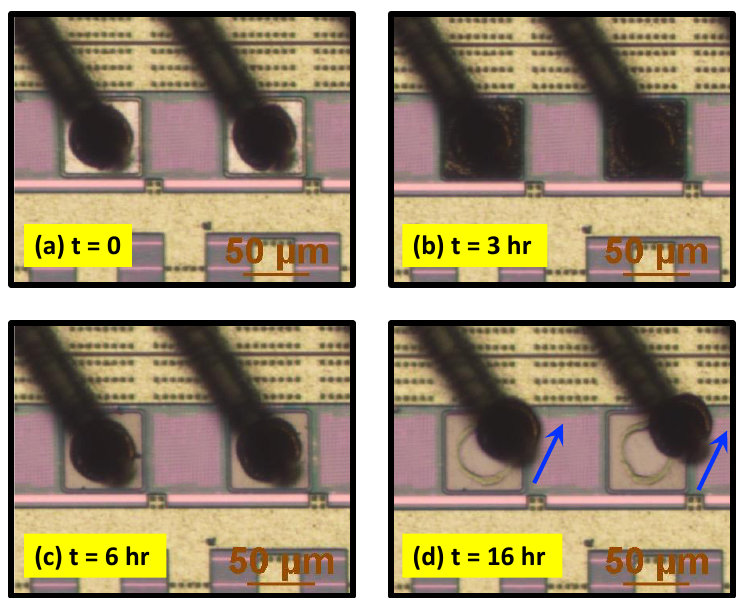
Figure 11. Real-time corrosion progression of WBD (Cu wire on Al bond pad) in 5 ppm F − , pH 5 solution ( a ) immediately after immersion; ( b ) Al pad completely corroded in about 3 h; ( c ) Al pad completely removed, revealing the underneath layer; and ( d ) Cu bonding ball lift-off, revealing no Al left on the bonded region.